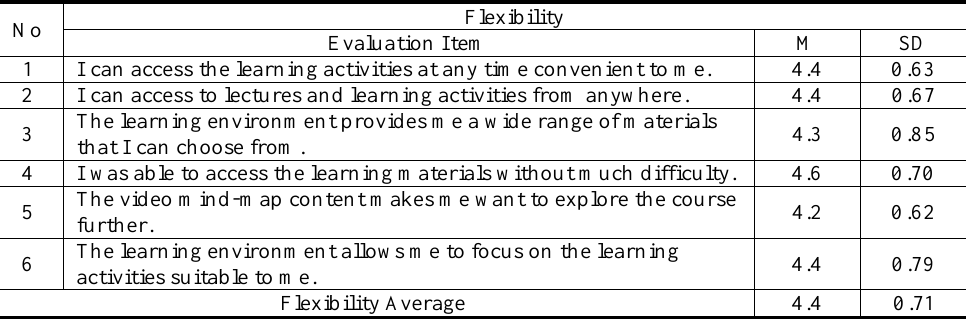
Descriptive Results of Flexibility Level